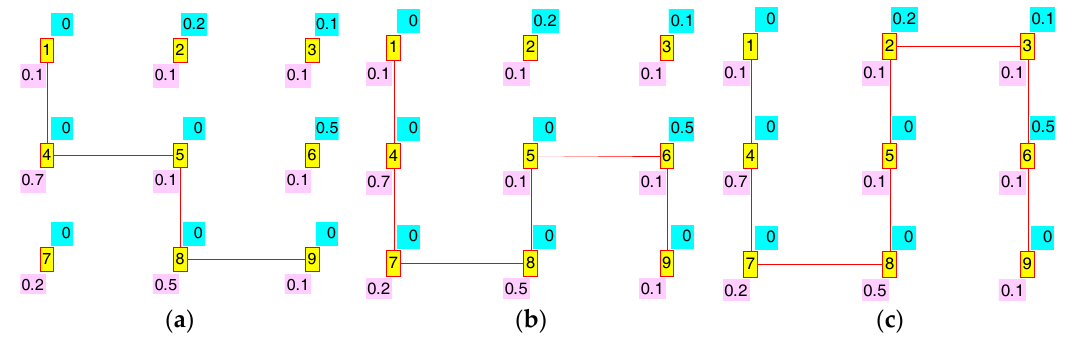
Figure 9. ( a ) R(t) = 1, S(t) = 0.3; ( b ) R(t) = 0.4, S(t) = 0.1; ( c ) R(t) = 0, S(t) = 0.